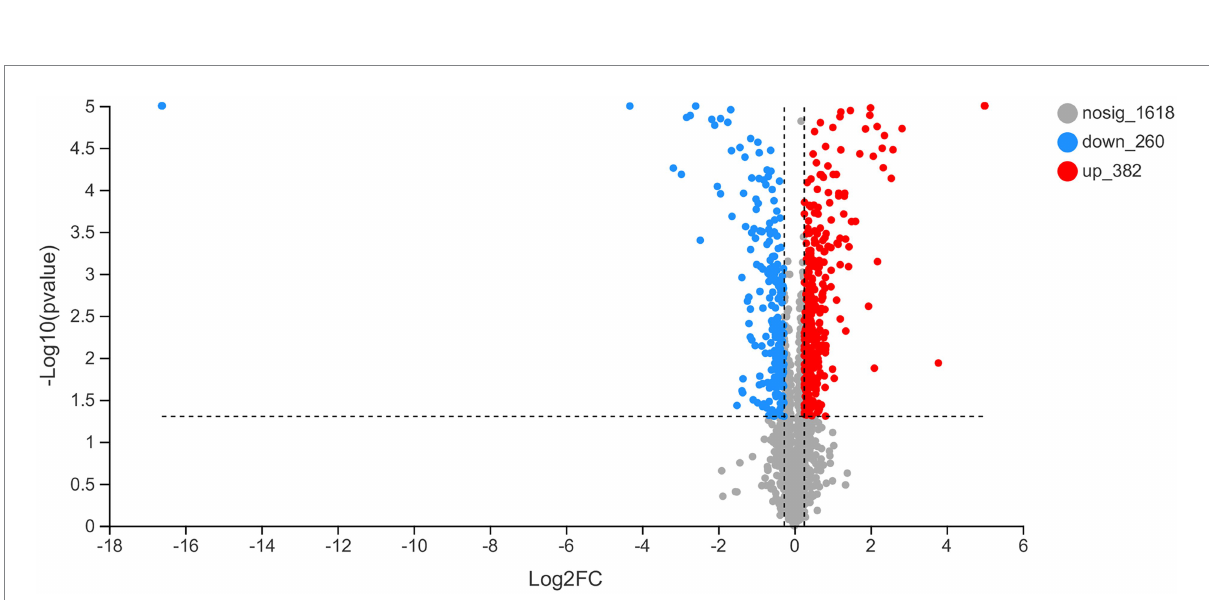
FIGURE 7 Changes in the proteome of Escherichia coli K12 following RcsC deletion. Volcano plots of the 2,260 identified proteins are shown. Red dots represent proteins with fold change values > 1.20. Blue dots represent proteins with fold change values < 0.83 ( p <